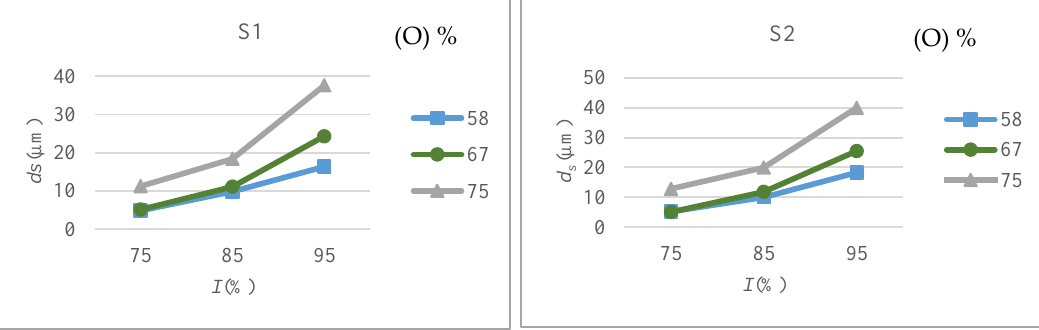
Figure 6. Depth per scan ( d s ) as a function of intensity ( I ) and overlap ( O ) for scanning pattern S1 and S2.